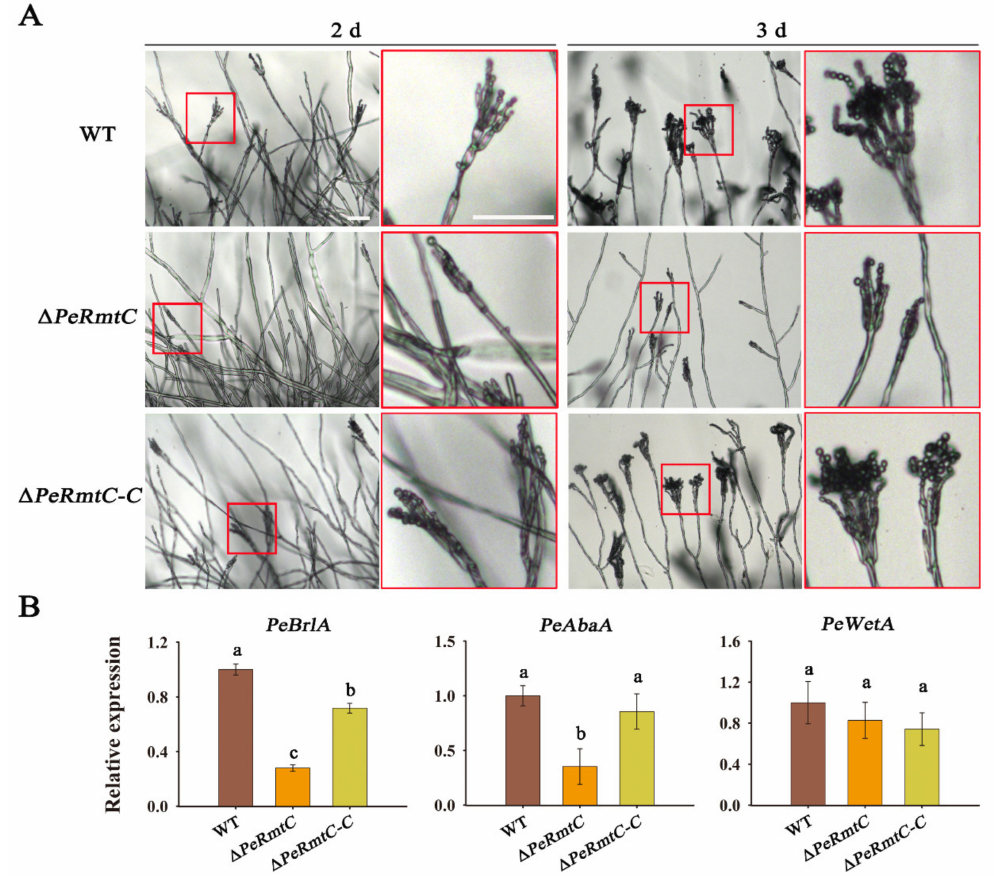
Figure 4. Effects of PeRmtC on conidiophore development. ( A ) Morphology observation of the conidiogenesis in the WT strain, ∆ PeRmtC , and ∆ PeRmtC-C . Scale bars indicate 40 µ m. Close-up views with red borders show the conidiophore morphologies of corresponding strains. ( B ) Expression analysis of the core regulatory genes in conidiation. The experiments were performed with three biological replicates. Columns with different letters are significantly different ( p <